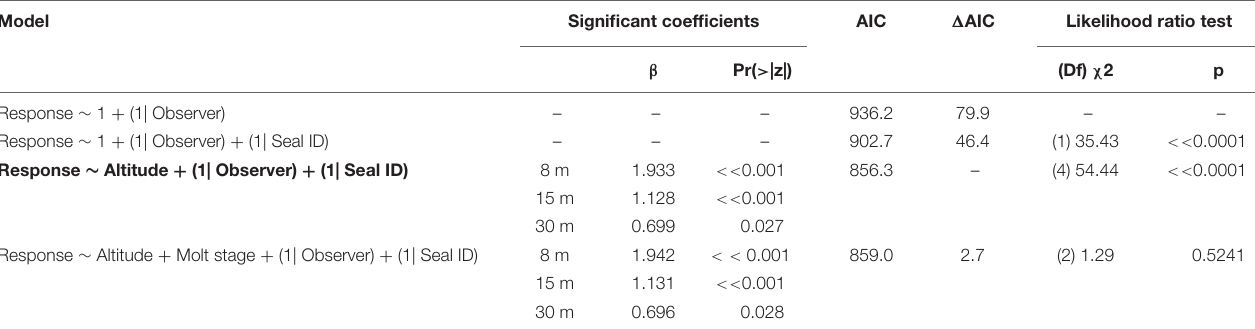
TABLE 8 | Generalized ordinal logistic mixed effects model results of behavioral response scores ( n = 387) from leopard seals at Cape Shirreff, Livingston Island in 2017 and 2018.